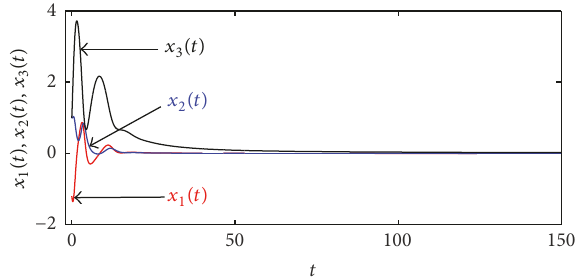
Figure 6: Stabilization of system (7) for 𝑞 = 0.96 and 𝐾 = −2 .